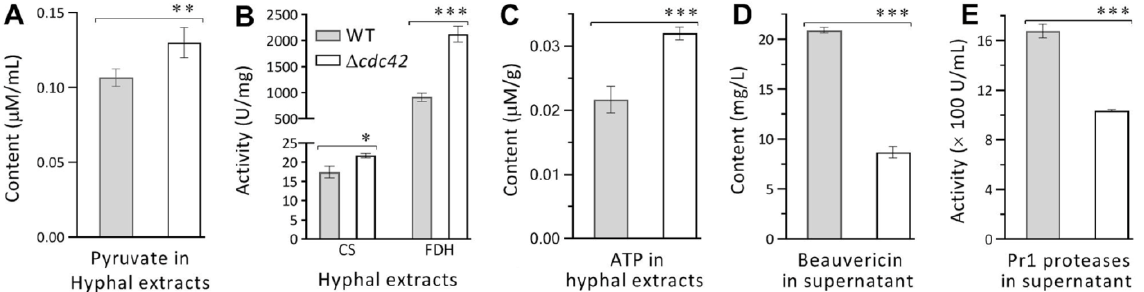
Figure 6. Impacts of cdc42 deletion on pyruvate metabolism, energy production, and virulence-related beauvericin and Pr1 proteases in B. bassiana . ( A – C ) Pyruvate contents, activities of TCA cycle-related citrate synthase (CS) and fumarate dehydrogenase (FDH), and ATP contents quantified from the extracts of 5-day-old SDBY cultures incubated at 25 °C, respectively. ( D ) Beauvericin contents measured from the supernatants of the 5-day-old SDBY cultures by HPLC. ( E ) Total activities of Pr1 family proteases quantified from the supernatants of the 5-day-old SDBY cultures. p < 0.05 *, 0.01 ** or 0.001 *** in Student’s t tests. Error bars: SDs from three independent samples analyzed.